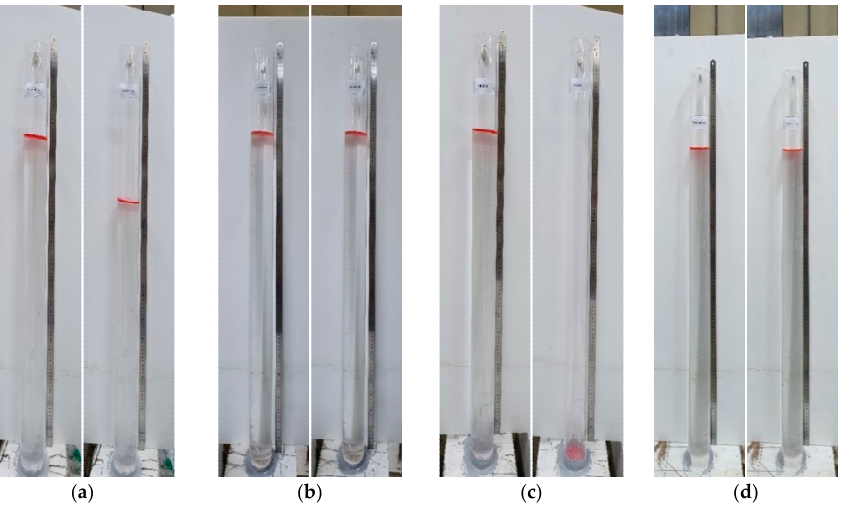
Figure 25. Results of water flow test: ( a ) 2.5 series; ( b ) 0.85 series; ( c ) Plain series; ( d ) healthy part.